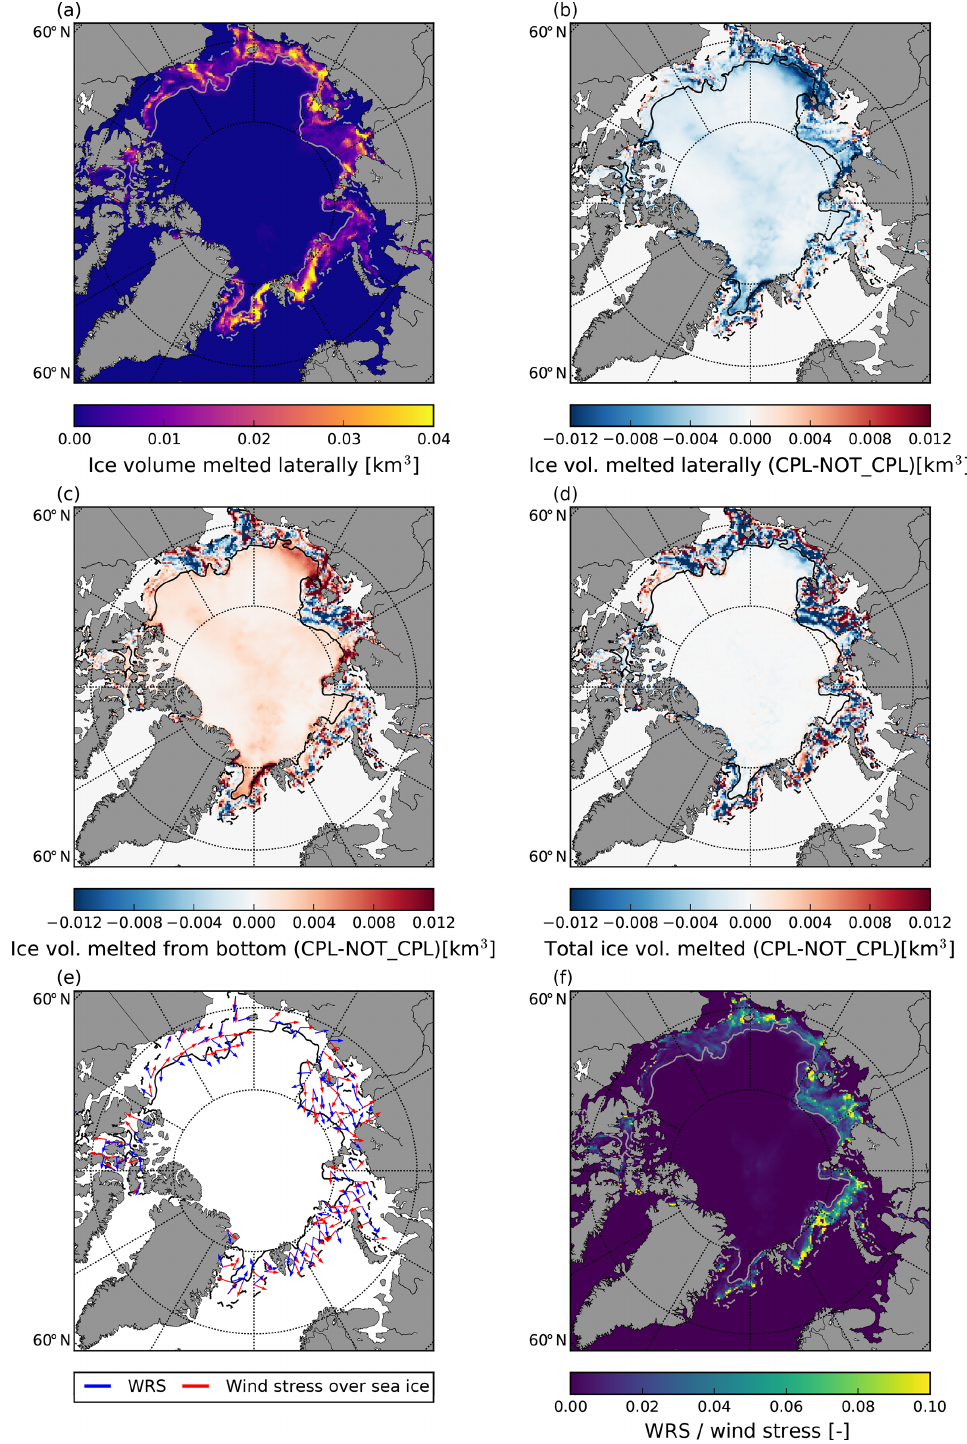
Figure 10. Volume of sea ice melted by lateral melt in the CPL simulation over the period between 4 August and 9 September 2010 (a) . Differences between the CPL and the NOT_CPL runs of lateral melt (b) , bottom melt (c) and total melt (d) . (e) Wind stress (red) and WRS (blue) averaged over the same period between 4 August and 9 September 2010 in the CPL simulation. Note that the WRS has been multiplied by a factor of 10 in order to improve readability. (f) Distribution of the relative magnitude of WRS over the wind stress. The grey contours represent the position of the ice edge ( c = 0 . 15) on the first day (solid line) and last day (dashed line) of the period considered in the CPL